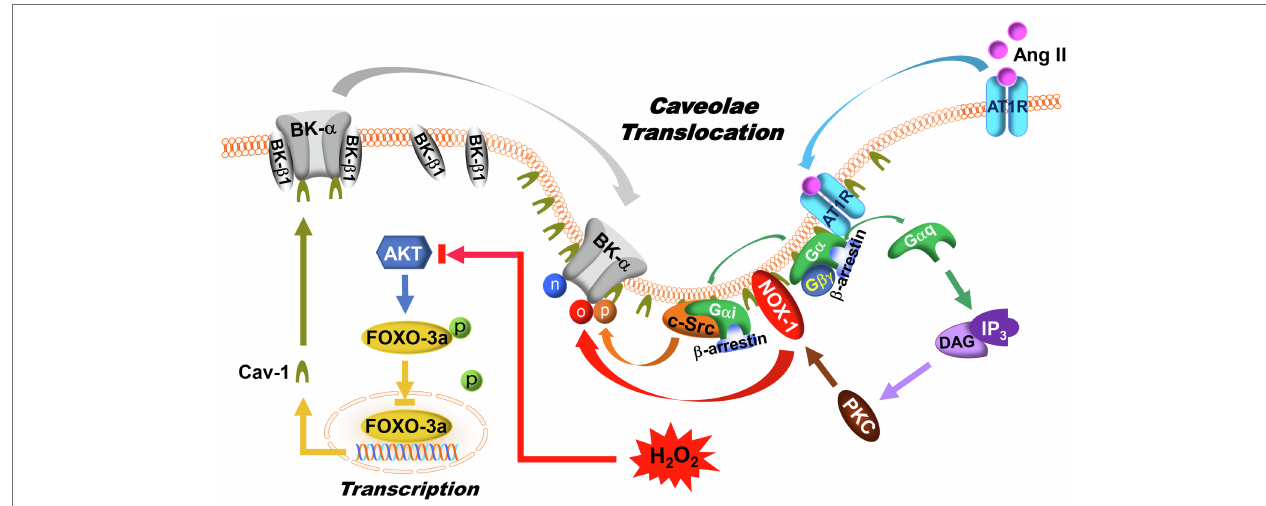
FIGURE 3 | Regulation of BK channels by AT1R signaling and caveolae compartmentalization. In DM, AT1R expression, and caveolae formation are upregulated in vascular SMCs. Upon Ang II activation, AT1R translocates to caveolae, where G-proteins, BK- α , NOX-1, and c-Src are colocalized. In caveolae, AT1R interacts with G α q to activate PKC and NOX-1 through IP 3 /DAG signaling pathway, leading to an increase of ROS production. Meanwhile, the G α i and β -arrestin complex induces c-Src activation. As a result of AT1R activation, BK- α protein oxidation, tyrosine phosphorylation, and tyrosine nitration are enhanced. In addition, AKT phosphorylates FOXO-3a, which in turn suppresses FOXO-3a nuclear translocation and reduces its transcriptional activities. With high glucose, increased ROS production inhibits AKT function, which promotes FOXO-3a nuclear translocation and facilitates Cav-1 expression. Since BK- β 1 is not present in the caveolae, an increase in BK- α compartmentalization in caveolae may lead to physical uncoupling between BK- α and BK- β 1 in vascular SMCs. The symbols “n,” “o,” and “p” represent protein nitration, oxidation, and phosphorylation,